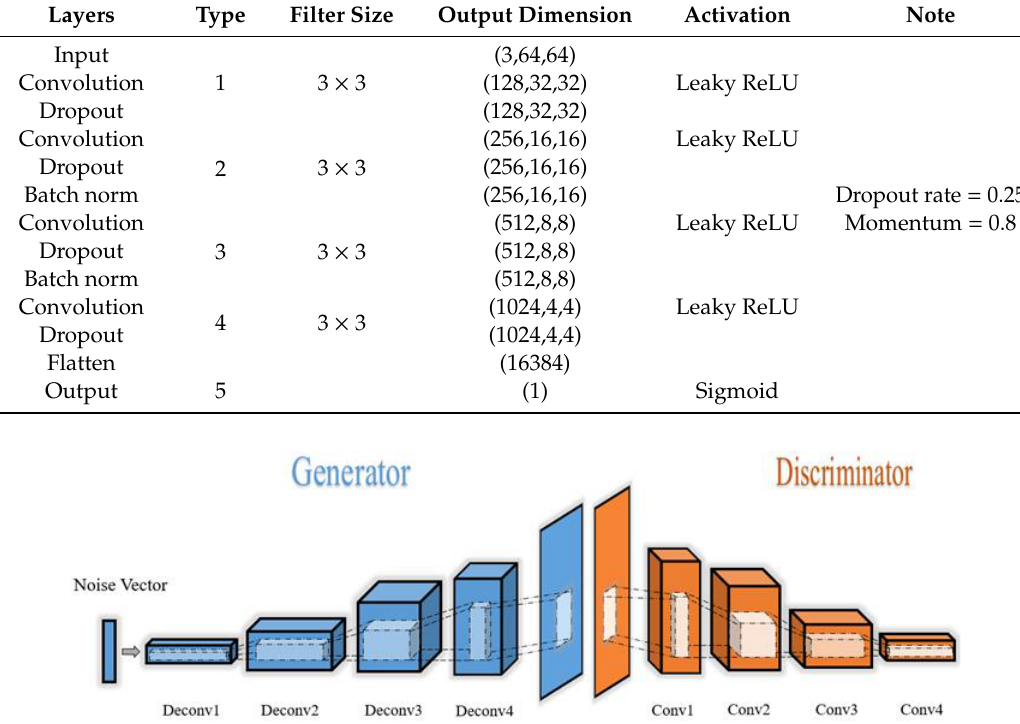
Figure 9. The structure of the discriminator. Table 3. Detailed architecture for the discriminator.